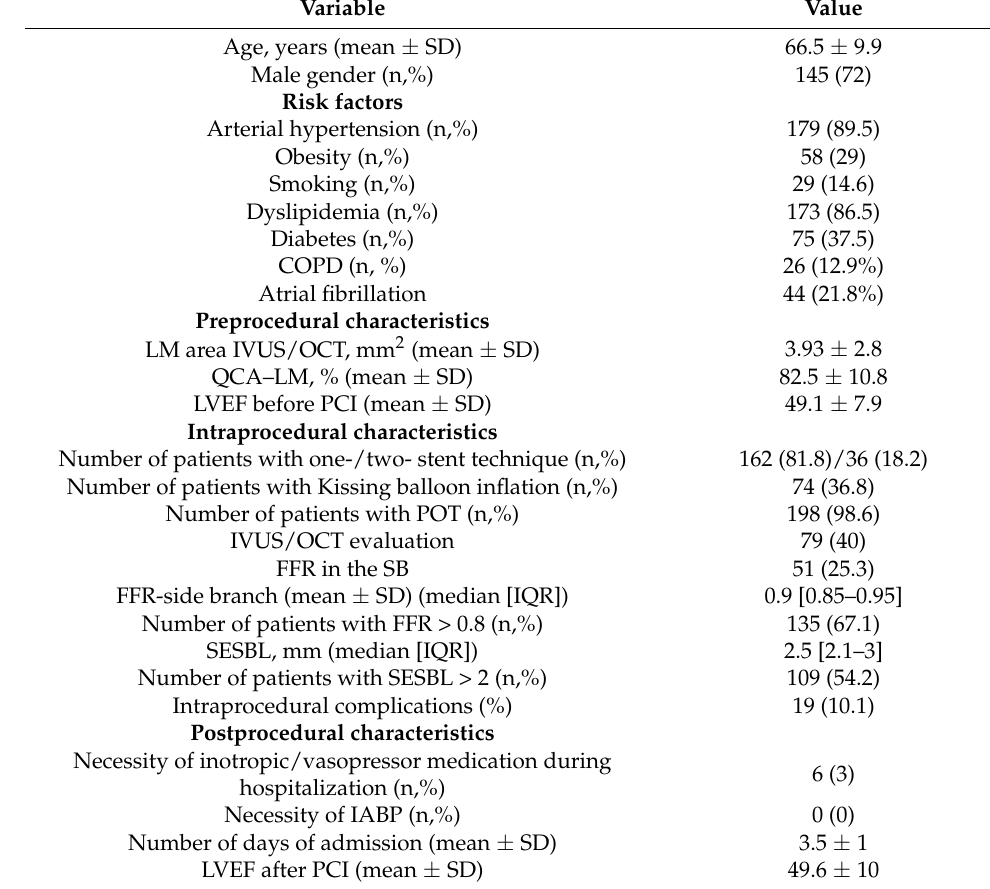
Table 1. General characteristics of the patients.